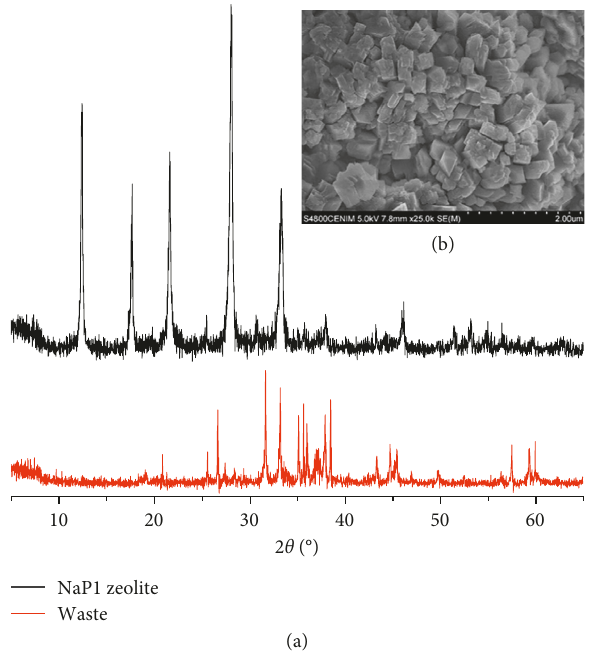
Figure 1: (a) X-ray diffraction patterns of Al-waste and Al-waste- NaP1. (b) Morphology of